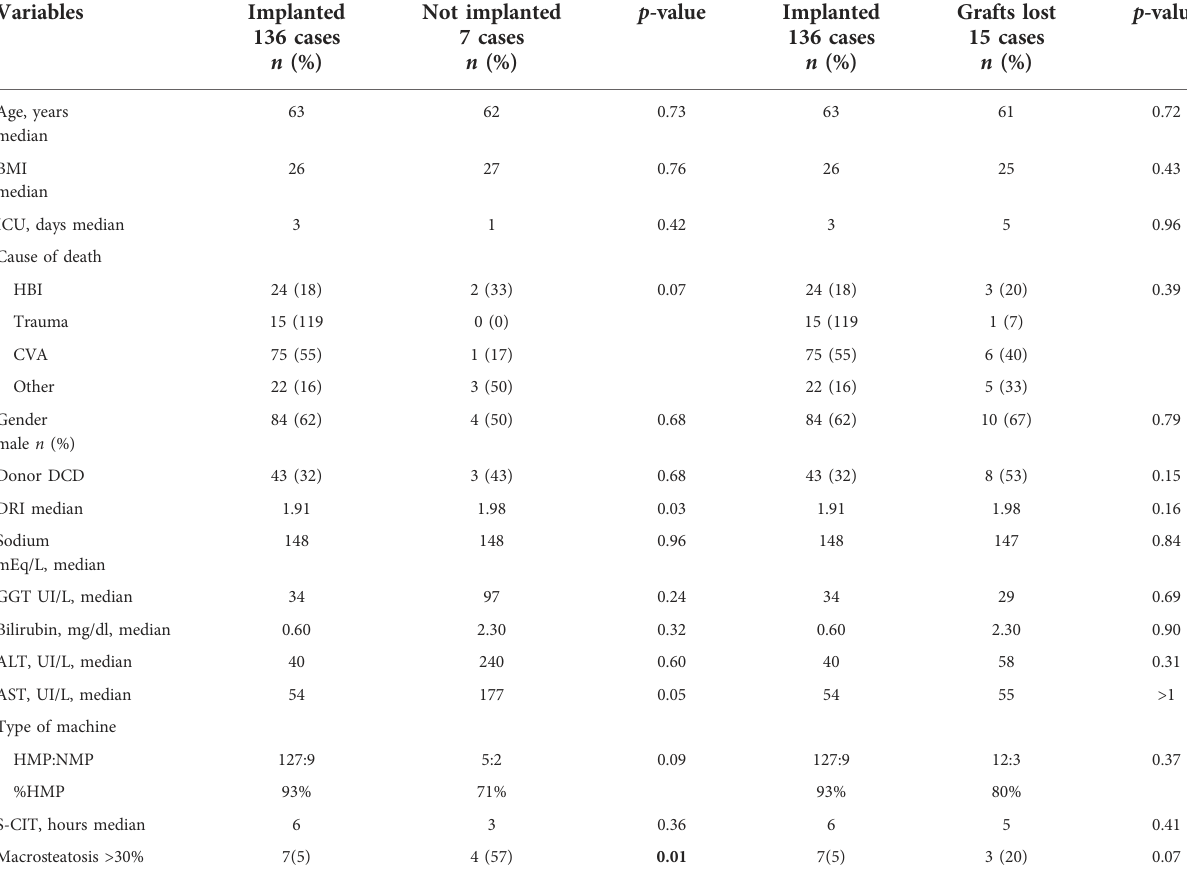
TABLE 4 Subgroups analysis of the donor and grafts risk factors predicting the discarded grafts and the grafts lost. Variables